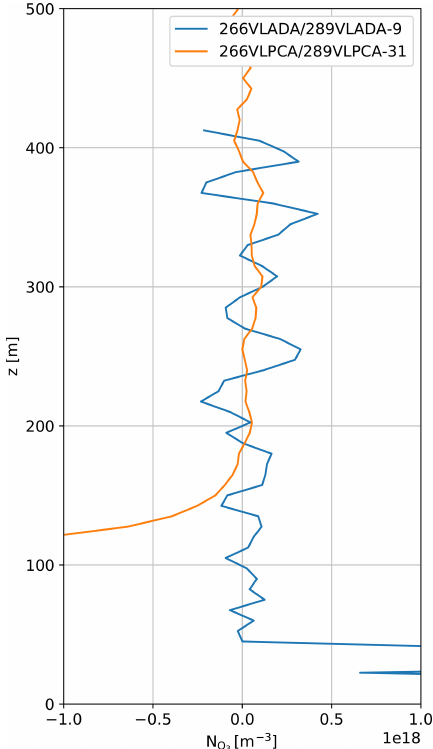
Figure 8. Error of the new very near-range receiver as a result of the differential efficiency (cid:51)η(z) using photon-counting (solid, orange) and analog detection mode (solid, blue). A typical ozone concentra- tion is about 1 × 10 18 m − 3